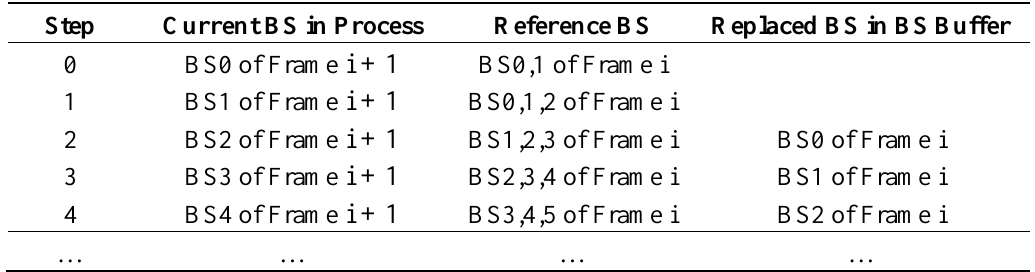
Figure 6. The processing order and the BS replacement strategy of the circular frame buffer for